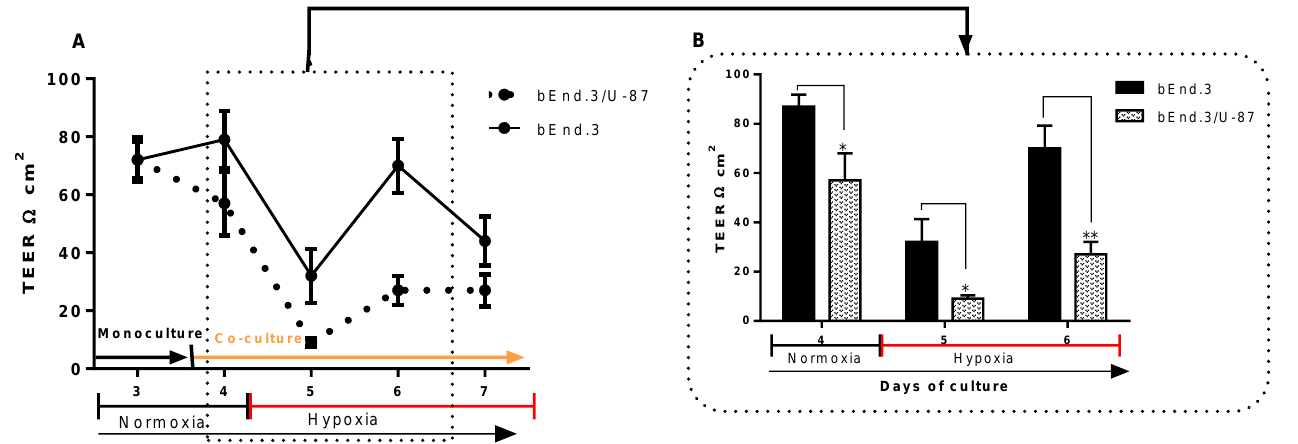
Figure 6. Transendothelial electrical resistance (TEER) of bEnd.3 monolayers. ( A ) Transendothelial electrical resistance (TEER) of bEnd.3 cells under hypoxic coculture with U-87 cells. Note that monocultures of bEnd.3 cells were introduced to coculture with U-87 cells after day 3 under normoxic conditions (TEER reading on day 4); thereafter, hypoxic conditions were introduced (after day 4 to the end of the experimental timeframe). ( B ) Illustrates the changes of TEER of bEnd.3 cells from normoxic to hypoxic incubation (* p < 0.05, ** p < 0.002), ( n = 3).